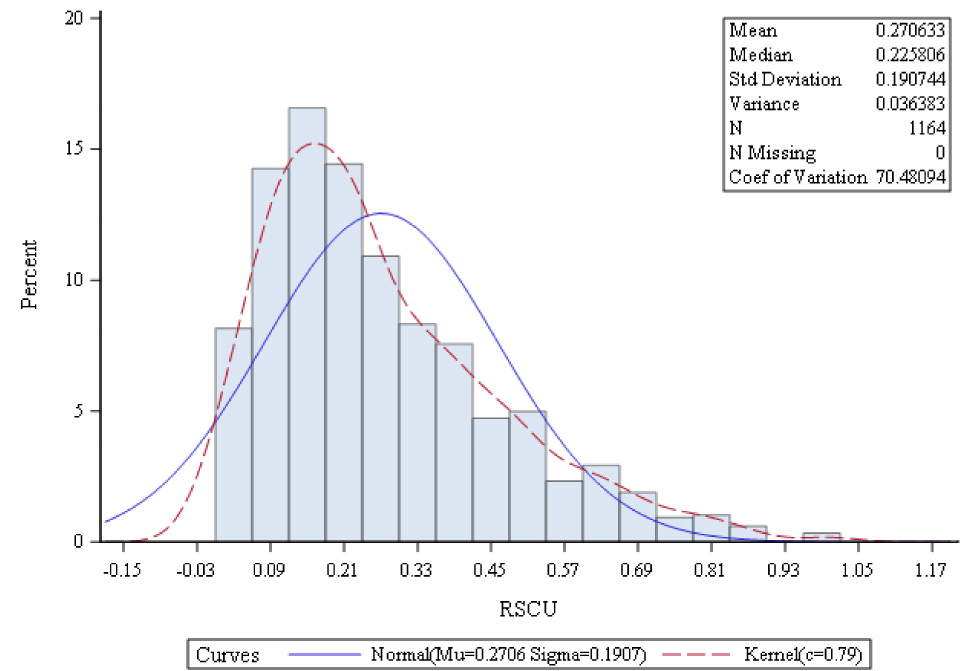
Figure 2. The normal distribution of the RSCU values in heat shock protein sequences based on mRNA for the Solanum lycopersicum cultivar Heinz 1706.